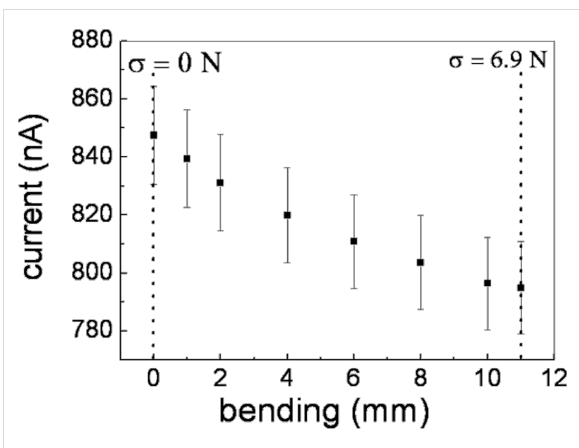
Figure 6: Electrical current variation due to the mechanical stress as measured on a PMMA/graphene sample.